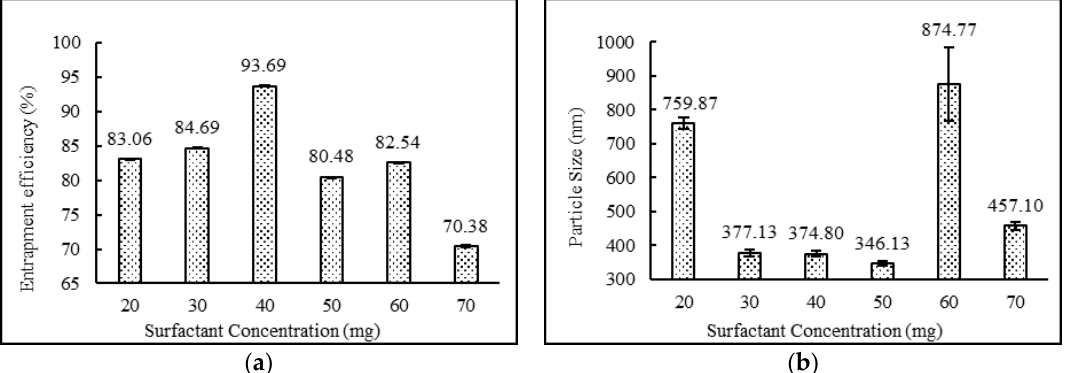
Figure 2. Effect of surfactant concentration (mg) on ( a ) entrapment efficiency (%) and ( b ) particle size (nm) of niosomes. ( N = 3, mean ± SD).